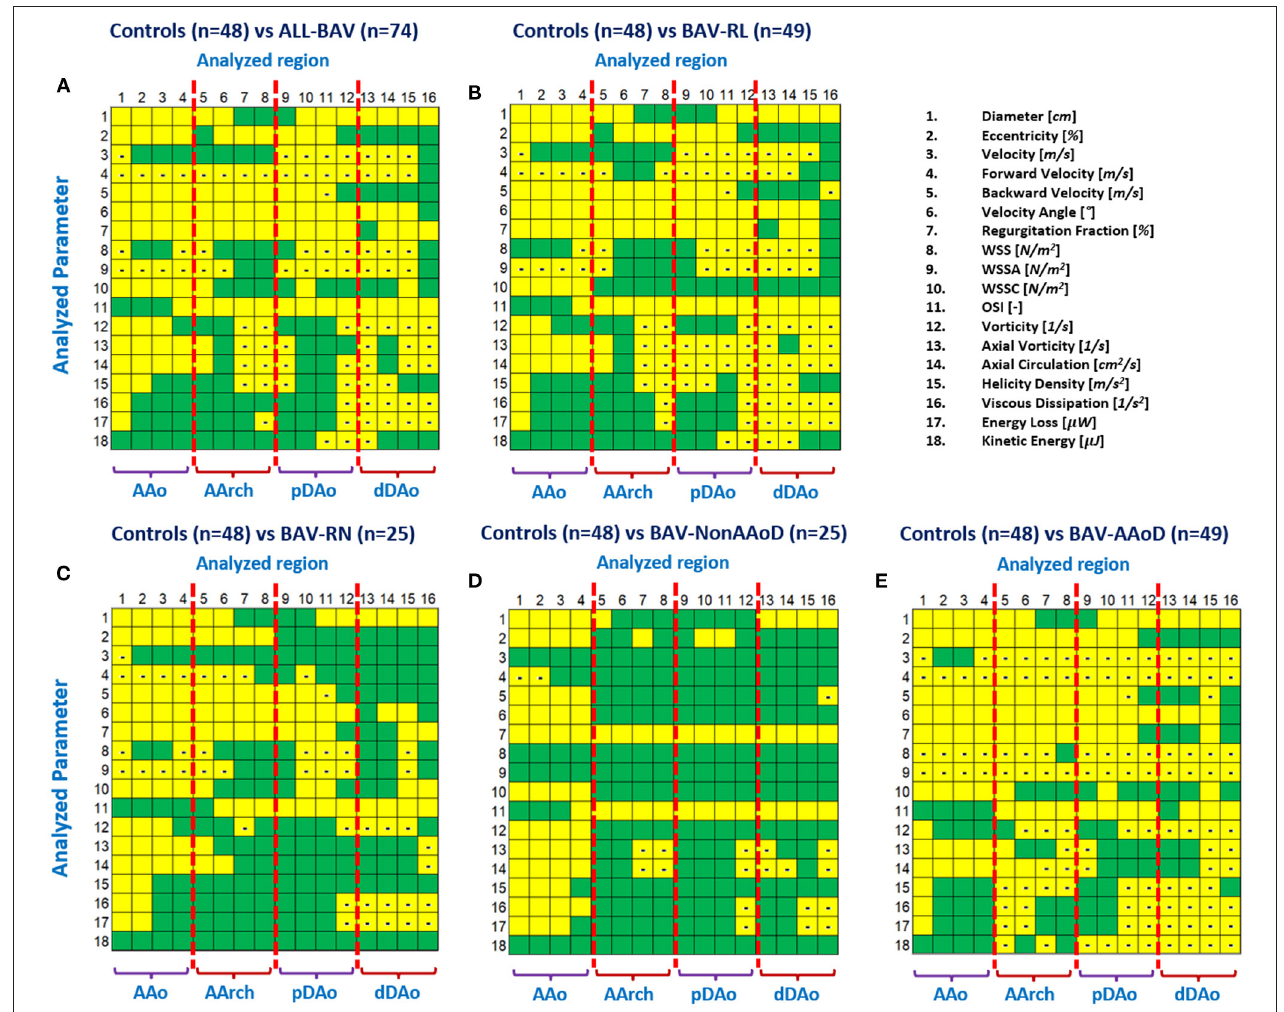
FIGURE 3 | Statistical differences between groups: (A) HV vs. all BAV; (B) HV vs. BAV-RL; (C) HV vs. BAV-RN; (D) HV vs. BAV-Non-AAoD; (E) HV vs. BAV-AAoD. Yellow marks highlight statistically significant differences between compared groups ( p -value < 0.05). The minus sign in yellow boxes indicates the value was lower in BAV than in